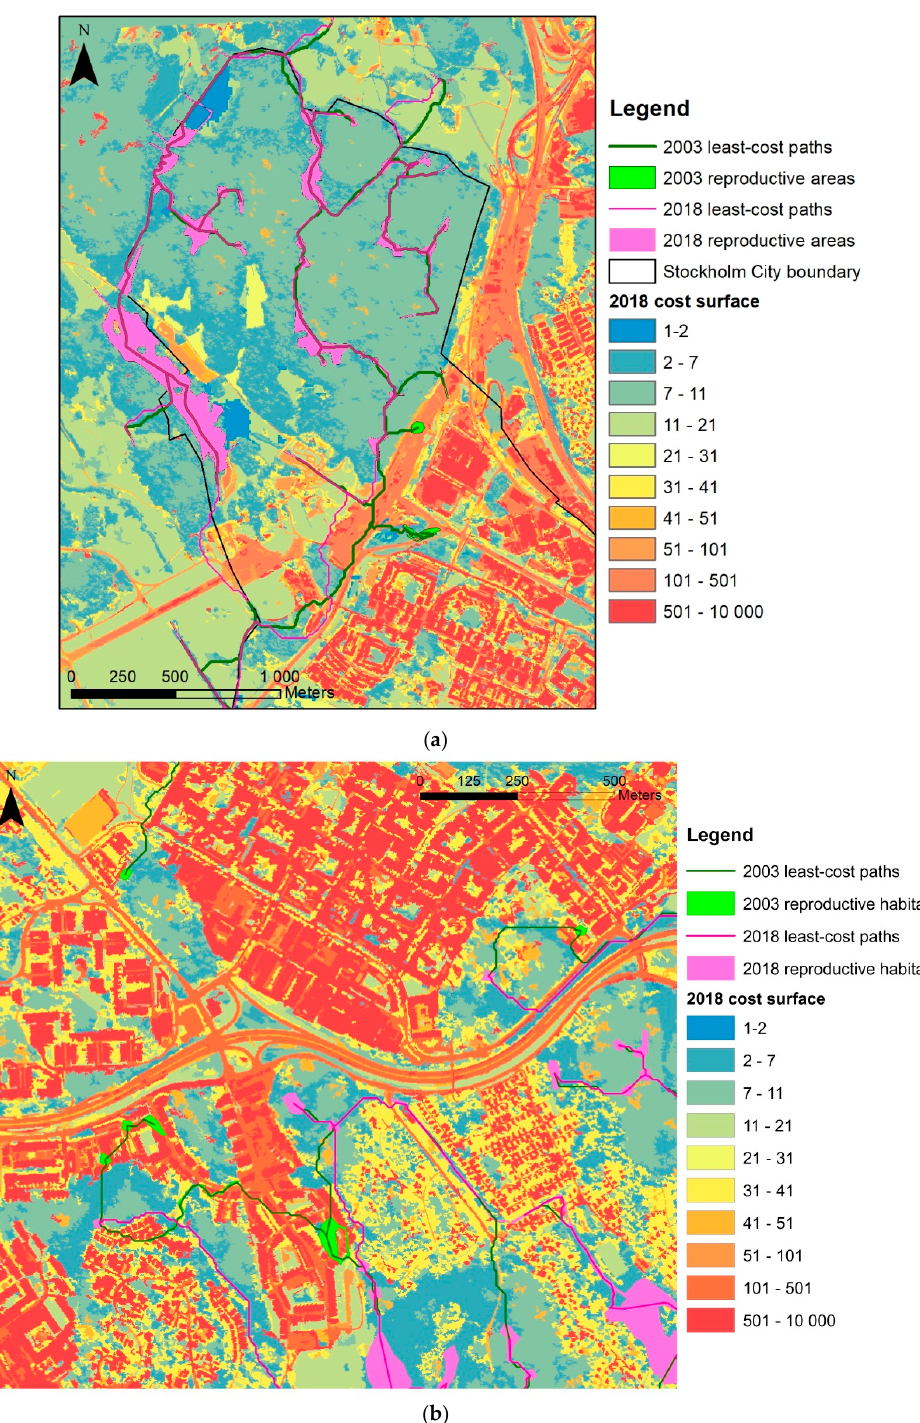
Figure 10. Loss of patches (in green) and consolidation of common toad habitat network near ( a ) Hansta Nature Reserve in the northwest of Stockholm City and ( b ) Skarpnäck in southern Stockholm City